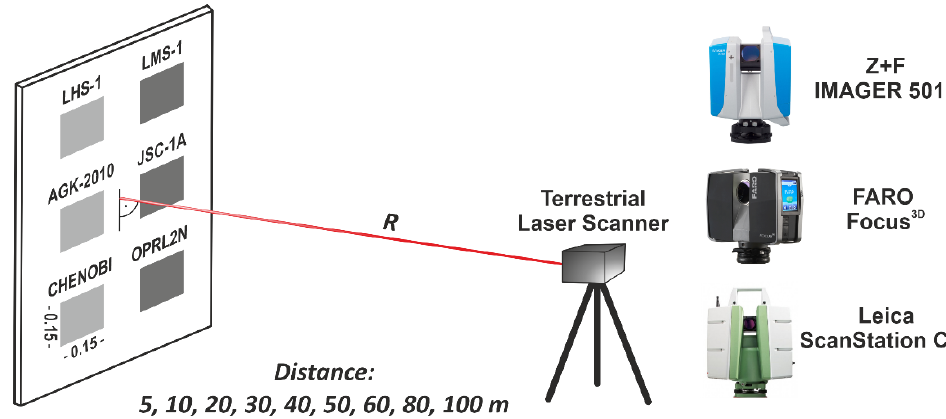
Figure 2. Setup of TLS measurements.